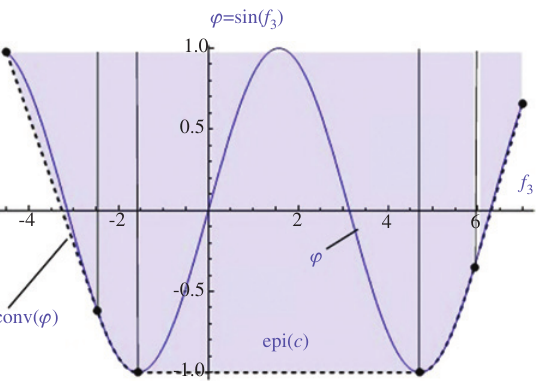
Figure 3: Convex envelop of the sine function in Example 4.